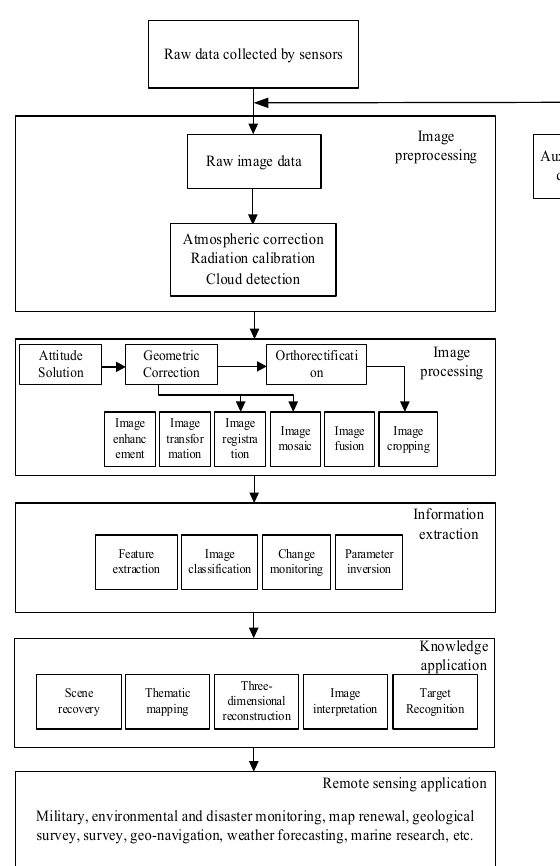
Figure 1. General procedure for remote sensing data processing(Gu et al., 2016)